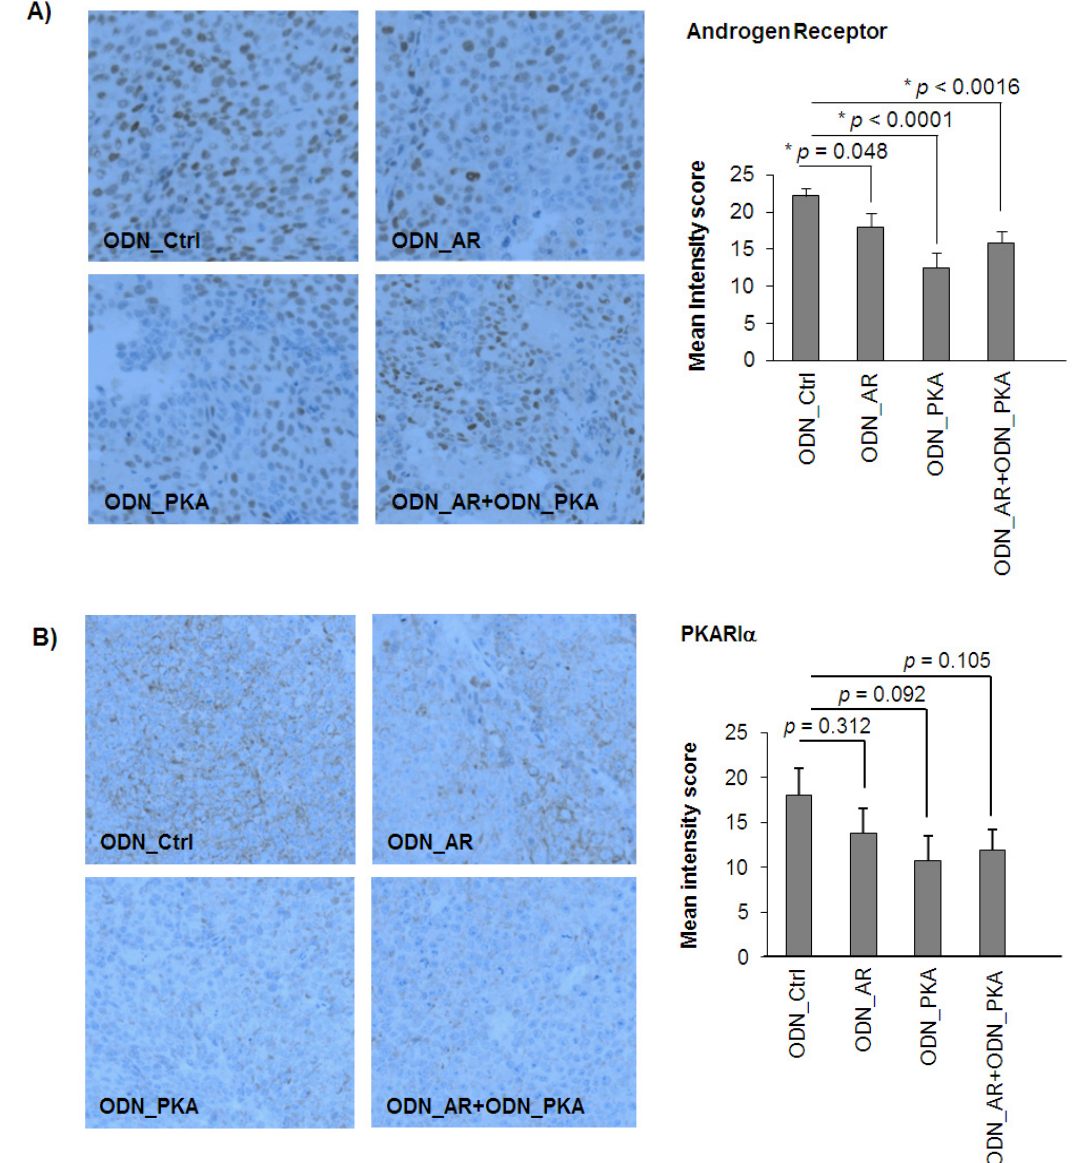
Figure 4. Immunohistochemical detection of AR and PKARI α in LNCaP xenograft tumors. After four weeks of treatment, animals were sacrificed and tumors excised, fixed and embedded in paraffin. A tissue microarray was established, as described in the Material and Methods. Sections (4 µm) were stained for AR ( α -AR) ( A ) and PKARI α ( α -PKARI α ) ( B ) and counterstained with hematoxylin. Images show representative tumor cores (magnification 200×). The AR was mainly found in the nucleus, whereas PKARI α was primarily detected in the cytoplasm. Slides were scored automatically by using TissueQuest software, and intensity scores were expressed as mean values ± S.E.M. ( * p < 0.05, t -test,